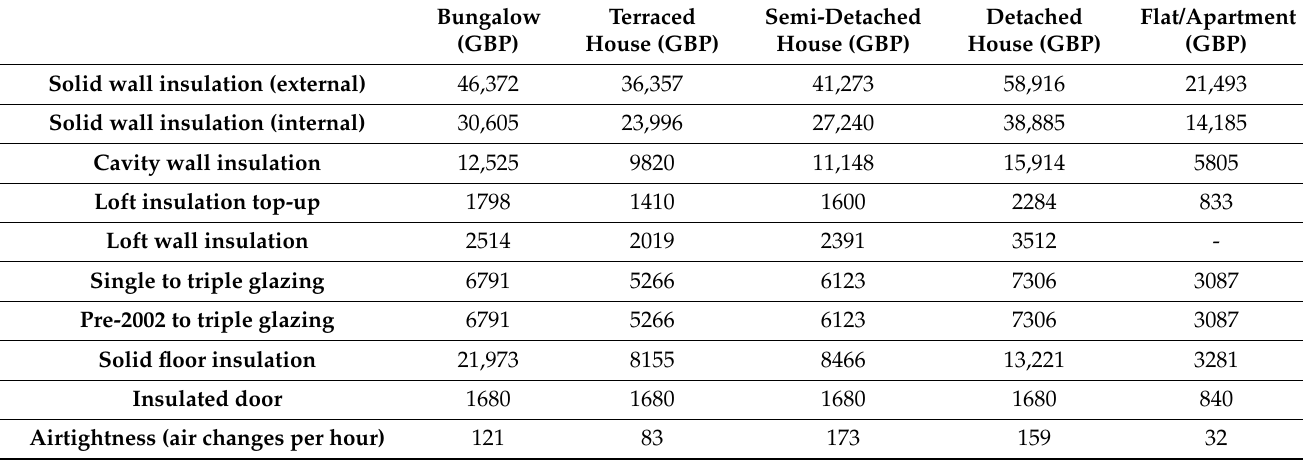
Table A4. Cost of retrofit per measure per house type (applicable to Passive